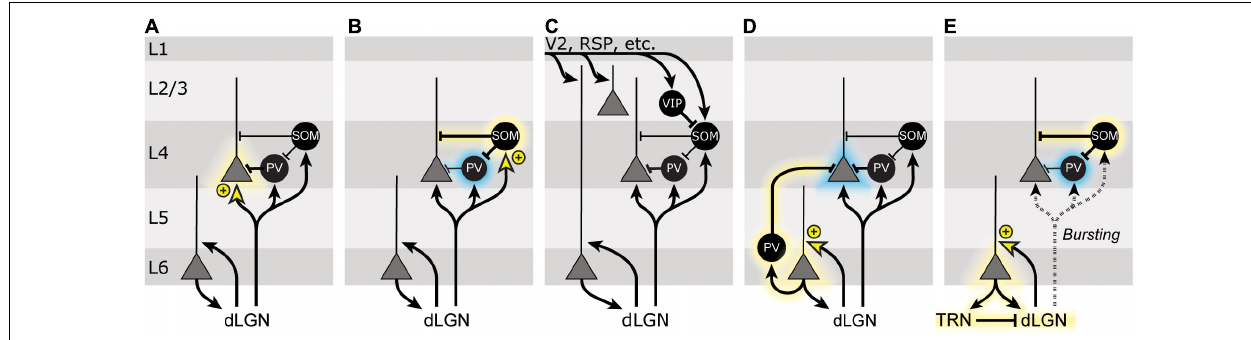
FIGURE 4 | Models of SRP. (A) Neurons in the dorsal lateral geniculate nucleus (dLGN) project to several populations of neurons in V1, including excitatory principal cells (gray triangles) and inhibitory interneurons (black circles) in multiple layers. SRP was originally interpreted as potentiation of a subset of thalamic inputs onto L4 principal cells (indicated by yellow arrowhead and + symbol), which would lead to an increased response of L4 principal cells (indicated by yellow halo) for familiar stimuli. The bulk of the evidence argues against this simple model of SRP. (B) Following SRP induction, somatostatin-positive (SOM+) inhibitory interneurons show heightened activity for familiar stimuli, and parvalbumin-positive (PV+) inhibitory interneurons show reduced activity for familiar stimuli (indicated by blue halo). This could be mediated by the potentiation of thalamic inputs onto L4 SOM+ cells, which inhibit L4 PV+ cells. (C) V1 receives a great deal of top-down feedback from other cortical and subcortical areas, including V2, retrosplenial cortex (RSP), and the basal forebrain. Changes in the feedback from these brain regions might explain some features of SRP, though how this model would also incorporate the necessity of local plasticity in V1 is unclear. (D) L6 corticothalamic cells also receive substantial thalamic input and have been implicated in SRP. Potentiation of thalamic inputs onto L6 principal cells might alter L4 activity via a population of PV+ cells known to inhibit other cortical layers. (E) Alternatively, L6 corticothalamic neurons could shift neurons in the dLGN from a tonic firing to a burst firing mode, via feedback to the thalamic reticular nucleus (TRN). This change in firing patterns could then preferentially recruit L4 SOM+ cells over PV+ cells to alter ongoing activity in